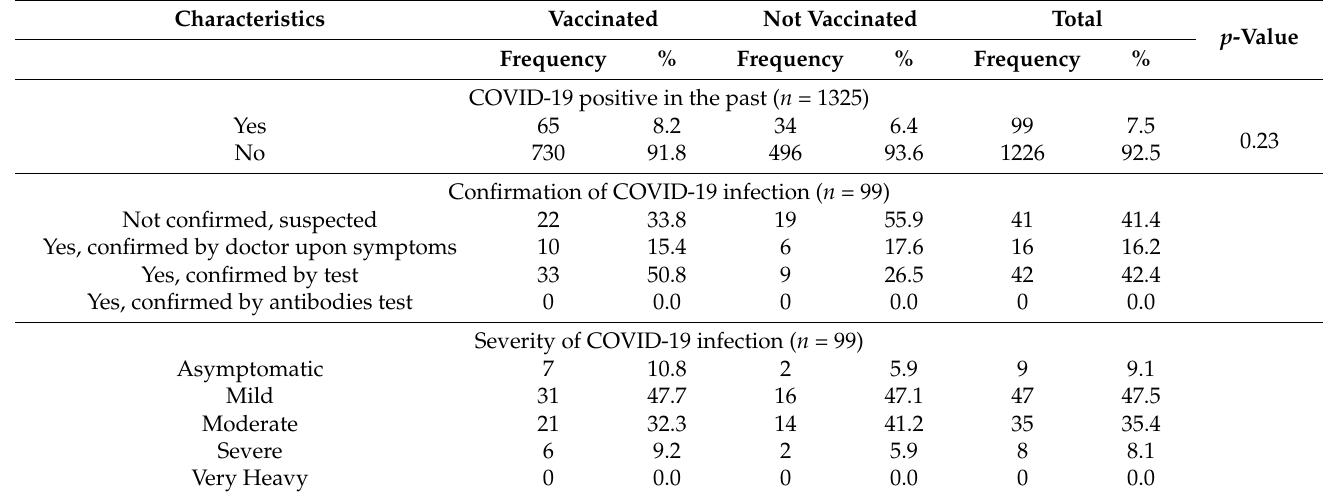
Table 5. History of COVID-19 virus